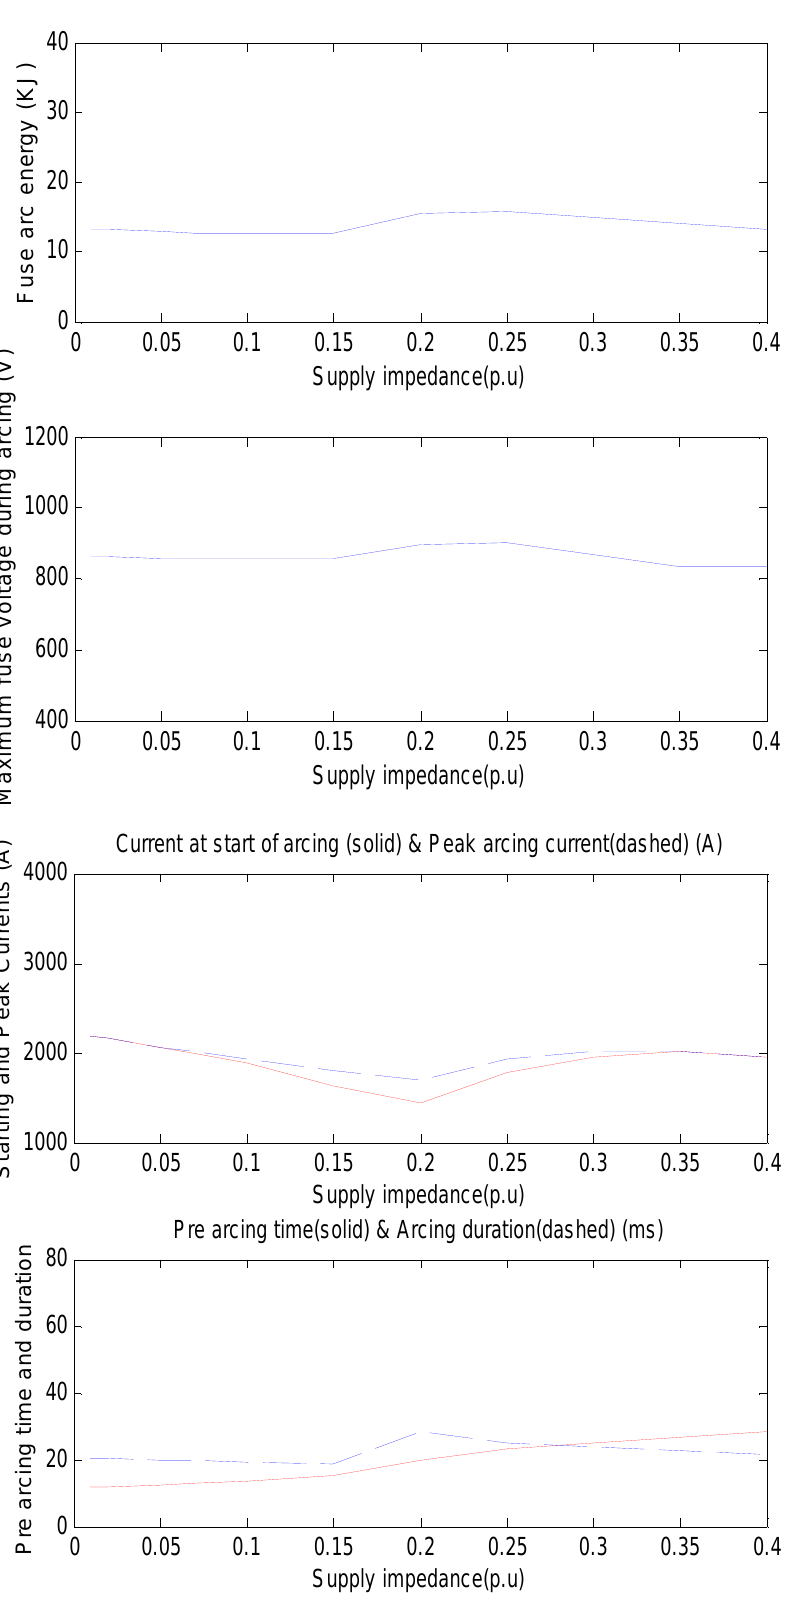
Figure 8. Variation of the arc energy (kJ) and fuse voltage (V), current at start of arcing (A), peak arcing current (A), pre arcing time (ms) and arcing duration (ms) versus the supply impedance when the 200 A fuse used as